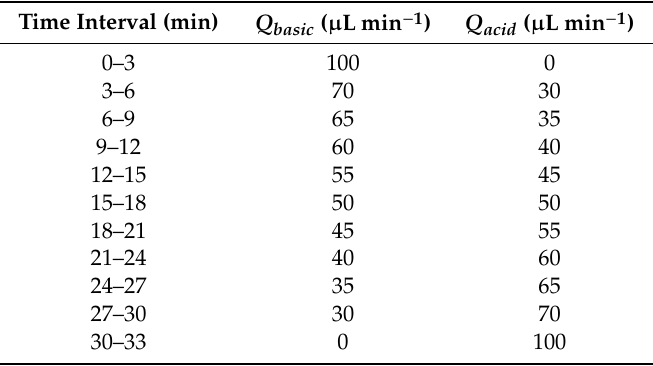
Table 2. Example of the flowrate protocol for one measurement, where every 3 min the analyte solution is obtained from a di ff erent combination of two solutions, acid and basic ones. Q acid refers to the flowrate of the acid solution, whereas Q basic refers to that of the basic one. The same protocol is used for another measurement, but with the interval